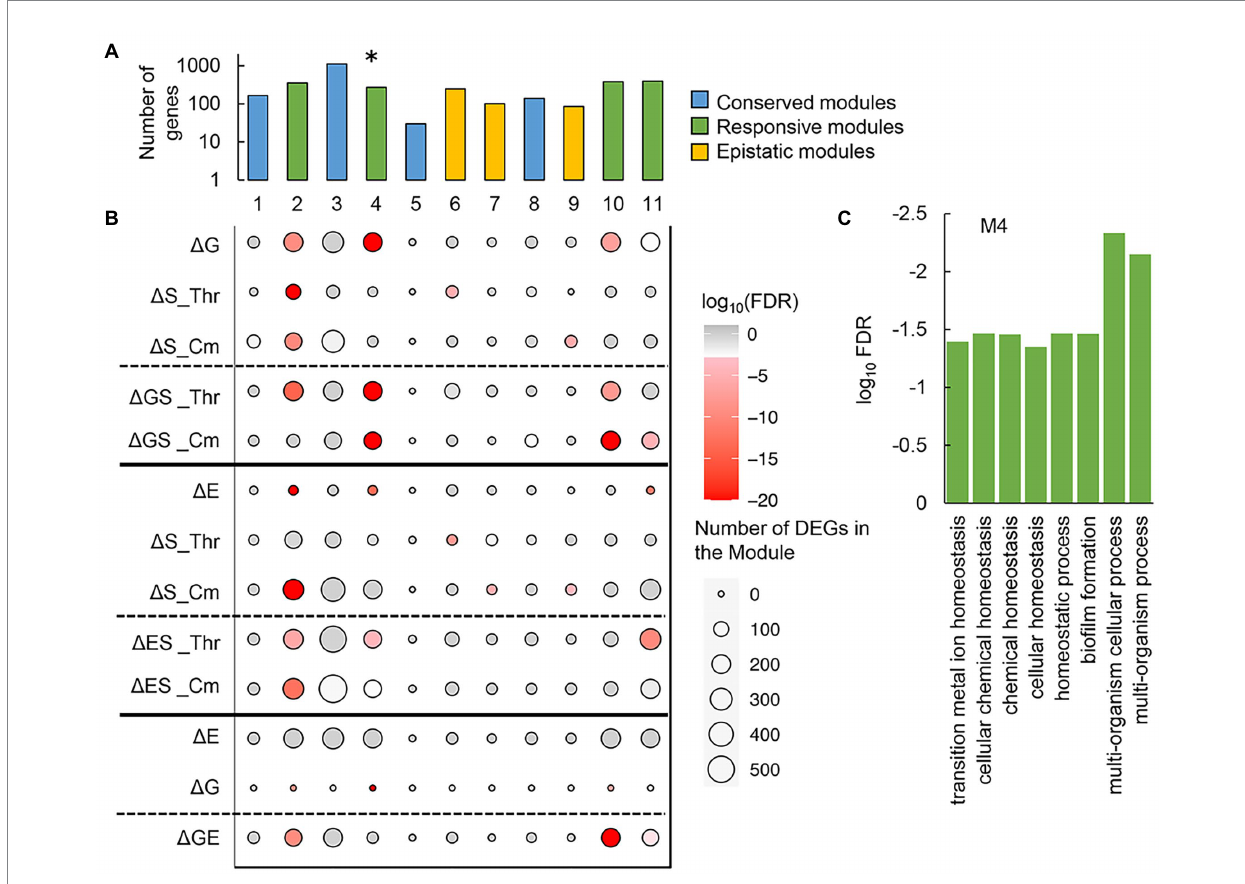
FIGURE 7 Gene modules clustered by weighted gene co-expression network analysis (WGCNA). (A) Gene modules newly constructed by WGCNA. A total of eleven modules newly constructed are shown. Color variation indicates the assigned types of gene modules. The asterisk indicates a significant correlation to the growth rate ( p < 0.01). (B) Enrichment of the DEGs in the gene modules. The numbers of the DEGs mediated by any of the individual and dual interruptions are represented as circles. Gradation in red indicates the statistical significance of enrichment. (C) Functional enrichment of M4. The enriched GO terms of high significance (FDR < 0.05) are indicated. Statistical significance is shown in a logarithmic